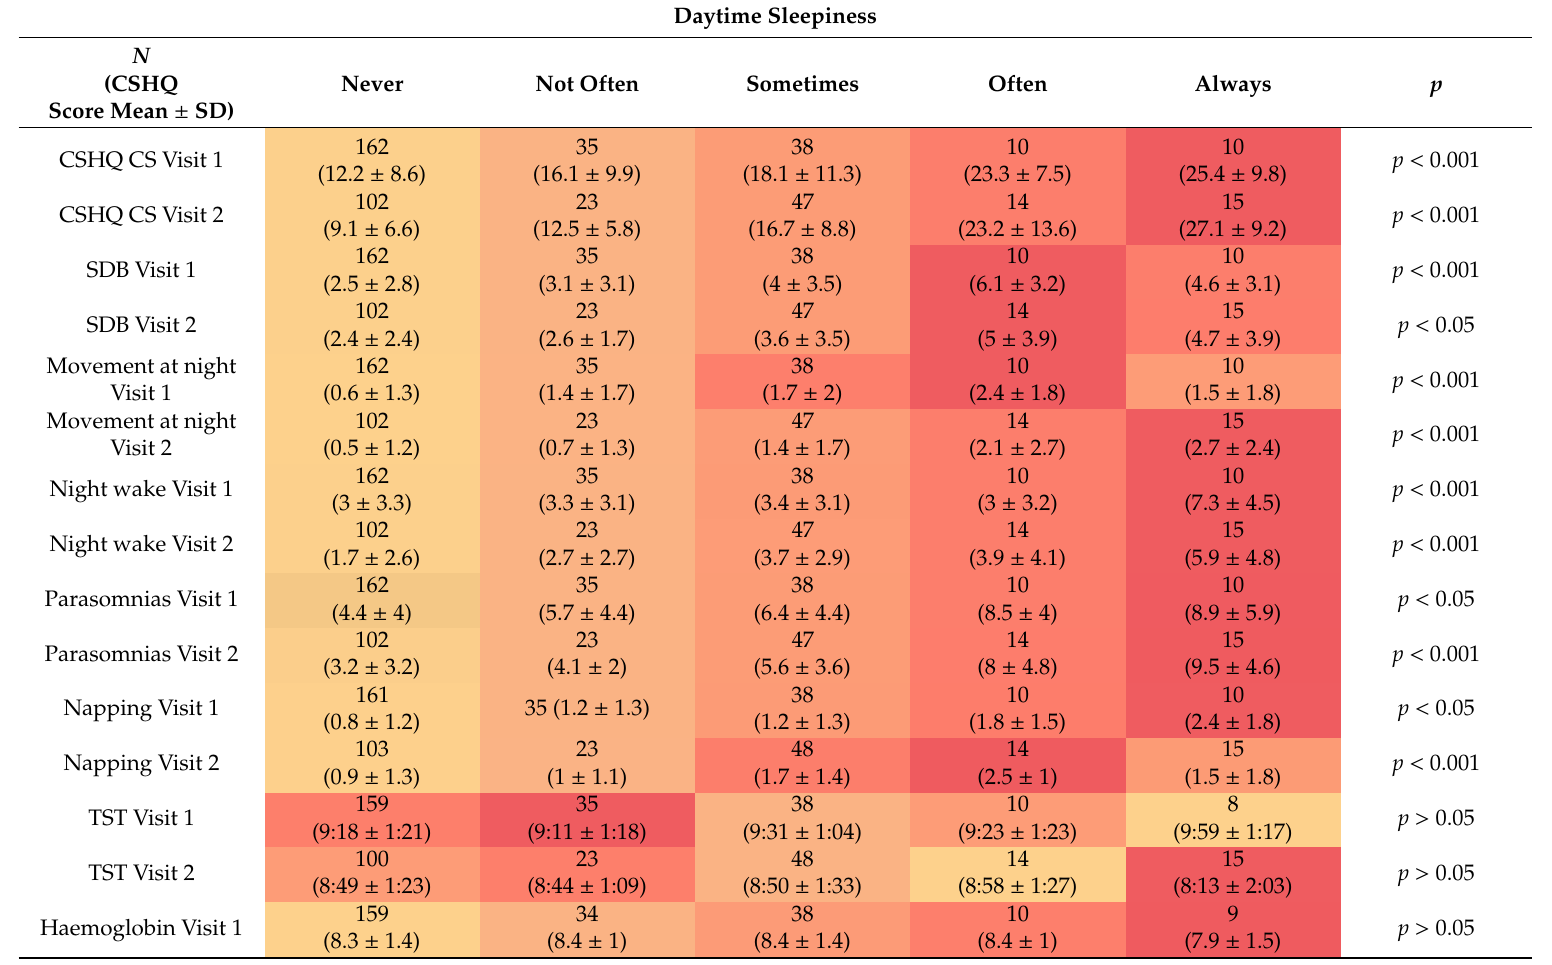
Table 5. Mean ( ± SD) for daytime sleepiness and CSHQ